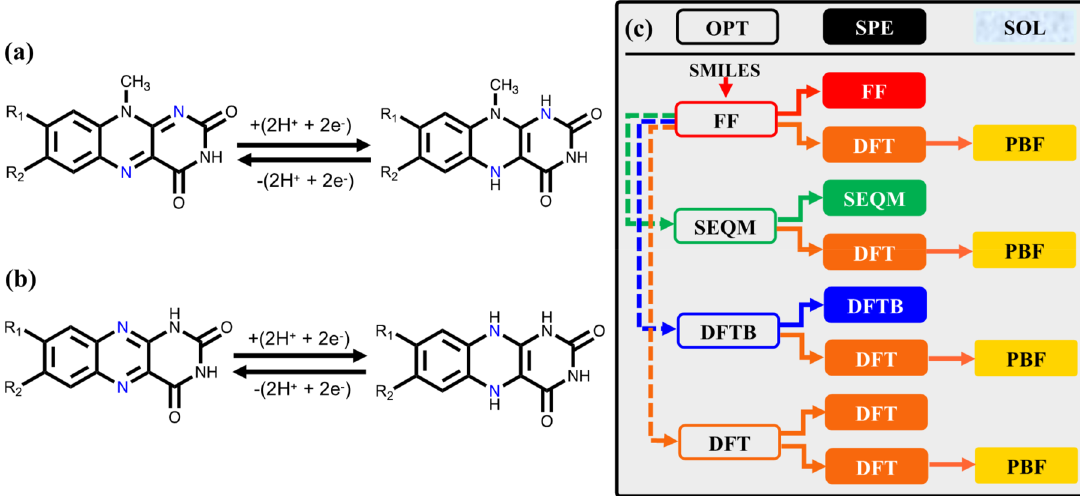
Figure 1. The two-electron–two-proton reaction takes place on ( a ) the heterocyclic nitrogen atoms of the adjacent rings, and ( b ) the heterocyclic nitrogen atoms of the same ring. ( c ) A graphical summary of the various levels of approximations used for estimating (cid:31) E rxn , E LUMO and E HOMO in this work. The text boxes with no background fill color represent geometry optimizations; the boxes with solid color background represent SPE calculations; the boxes with yellow background represent solution phase SPE calculations using an implicit aqueous solvent model. 2D molecule representations have been created using ChemDraw Professional [version 18.0.0.231(4318)] https ://www.perki nelme r.com/produ ct/chemd raw-profe ssion al-chemd rawpr o. Figure